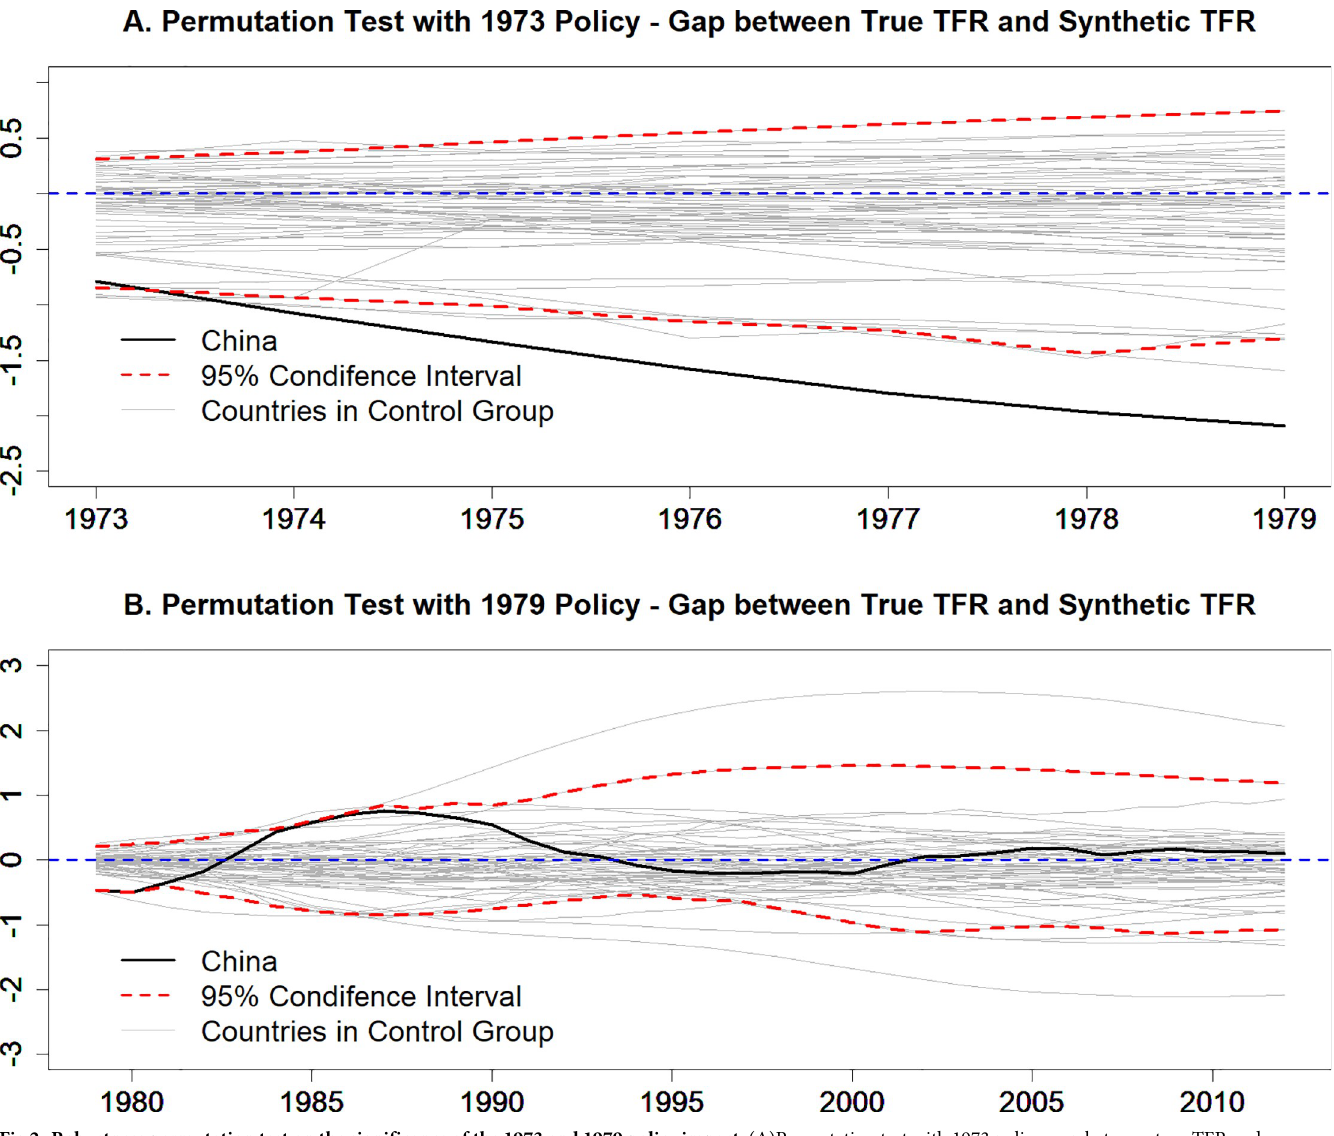
Fig 2. Robustness permutation test on the significance of the 1973 and 1979 policy impact. (A)Permutation test with 1973 policy–gap between true TFR and synthetic TFR. (B) Permutation test with 1979 policy–gap between true TFR and synthetic